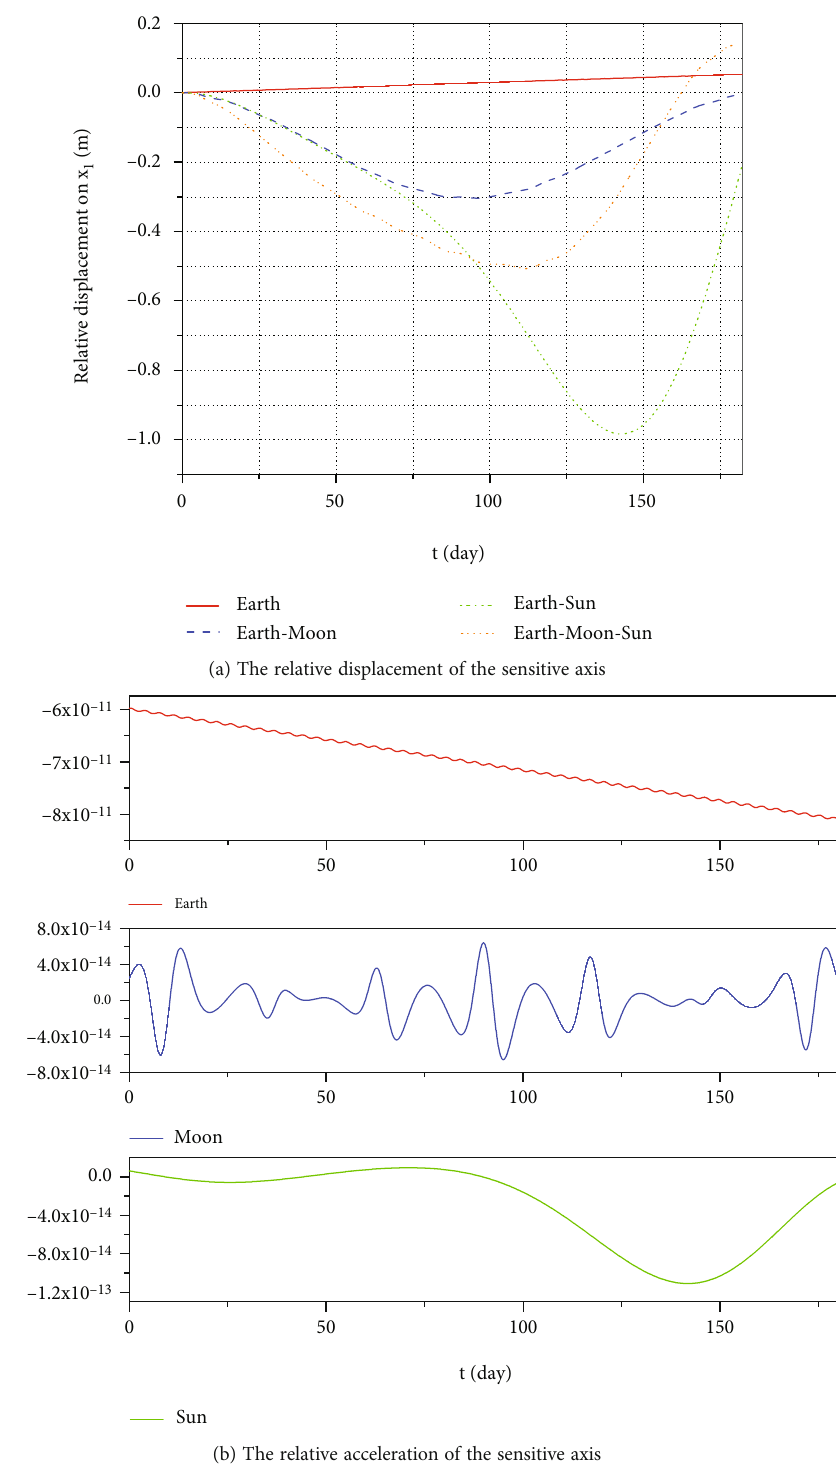
Figure 3: The e ff ect of the Earth-moon-sun system on the relative motion in the sensitive